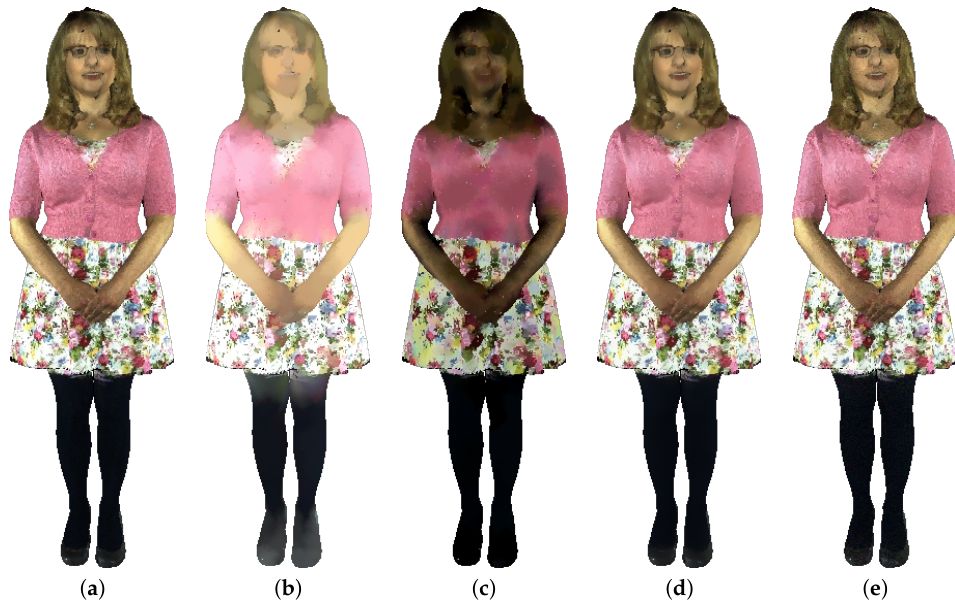
Figure 5. Filtering of a colored point cloud with several operators. Parameters are k = 8, σ = 15 with 20 iterations for ( a – e ) (see Section 4.2). ( a ) Original; ( b ) NLD ; ( c ) NLE ; ( d ) NLA ; ( e ) NLA 1 .